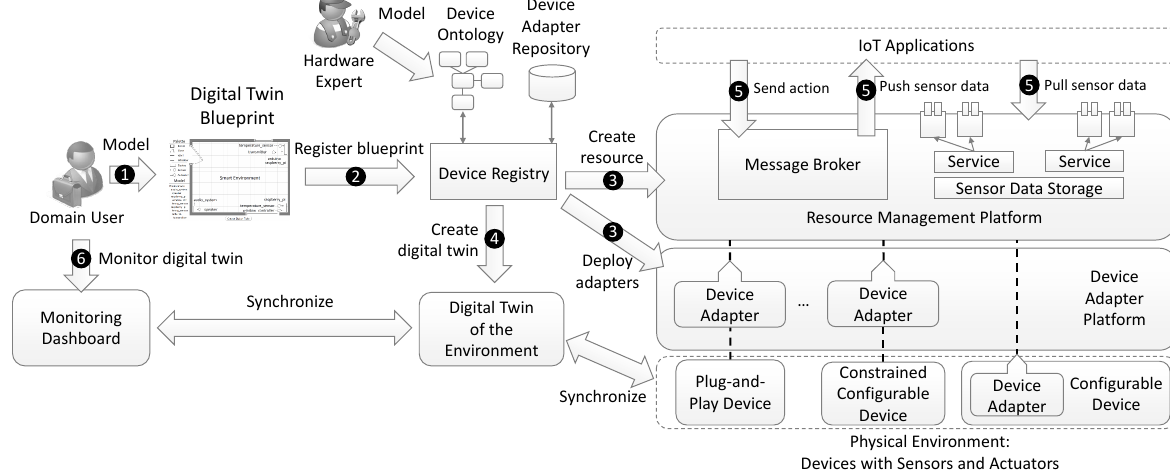
Figure 1. System architecture for the provisioning and configuration of